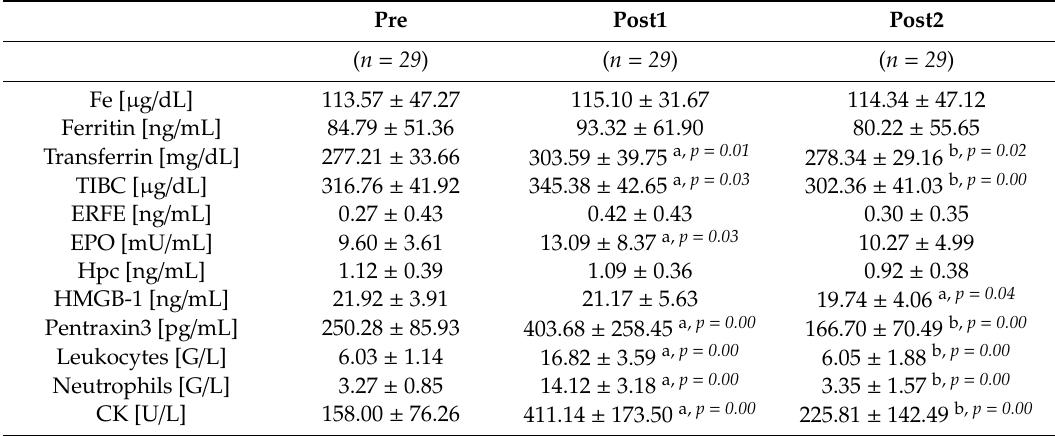
Table 2. The e ff ects of marathon running on the inflammation and iron metabolism in young man. Pre Post1 Post2 ( n = 29 ) 113.57 ±